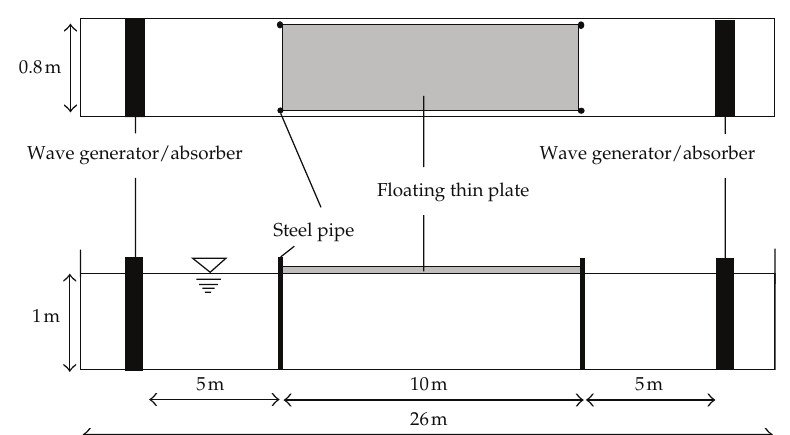
Figure 2: Wave basin with a floating thin plate utilized in Sakai et al. (cid:5) 3 (cid:6) . The upper and lower figures show its plan and side views, respectively.